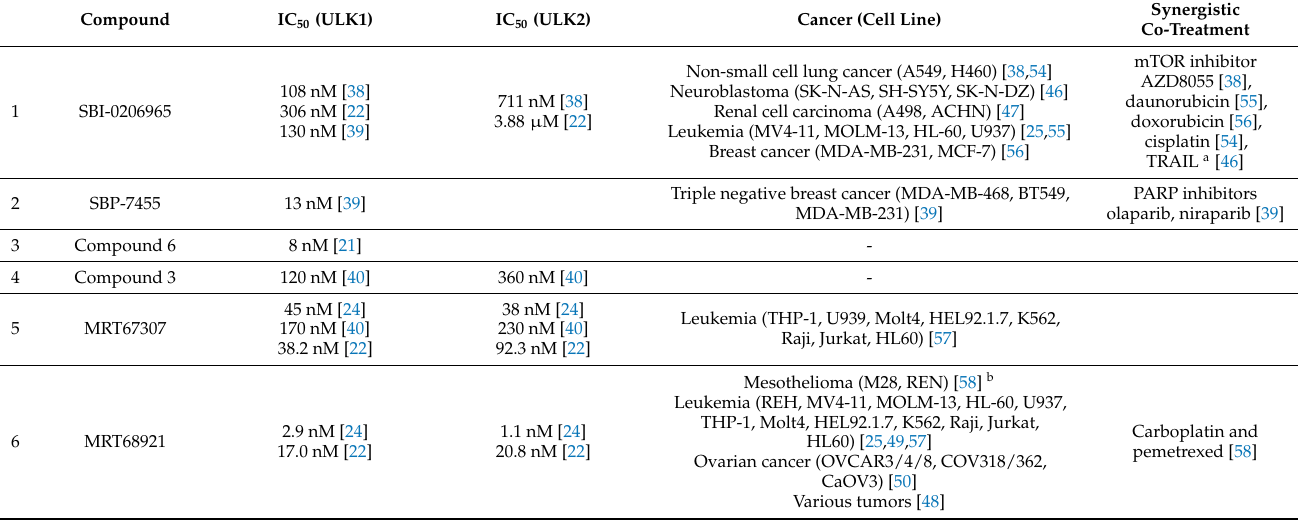
Table 1. ULK1/2 inhibitors as potential anticancer